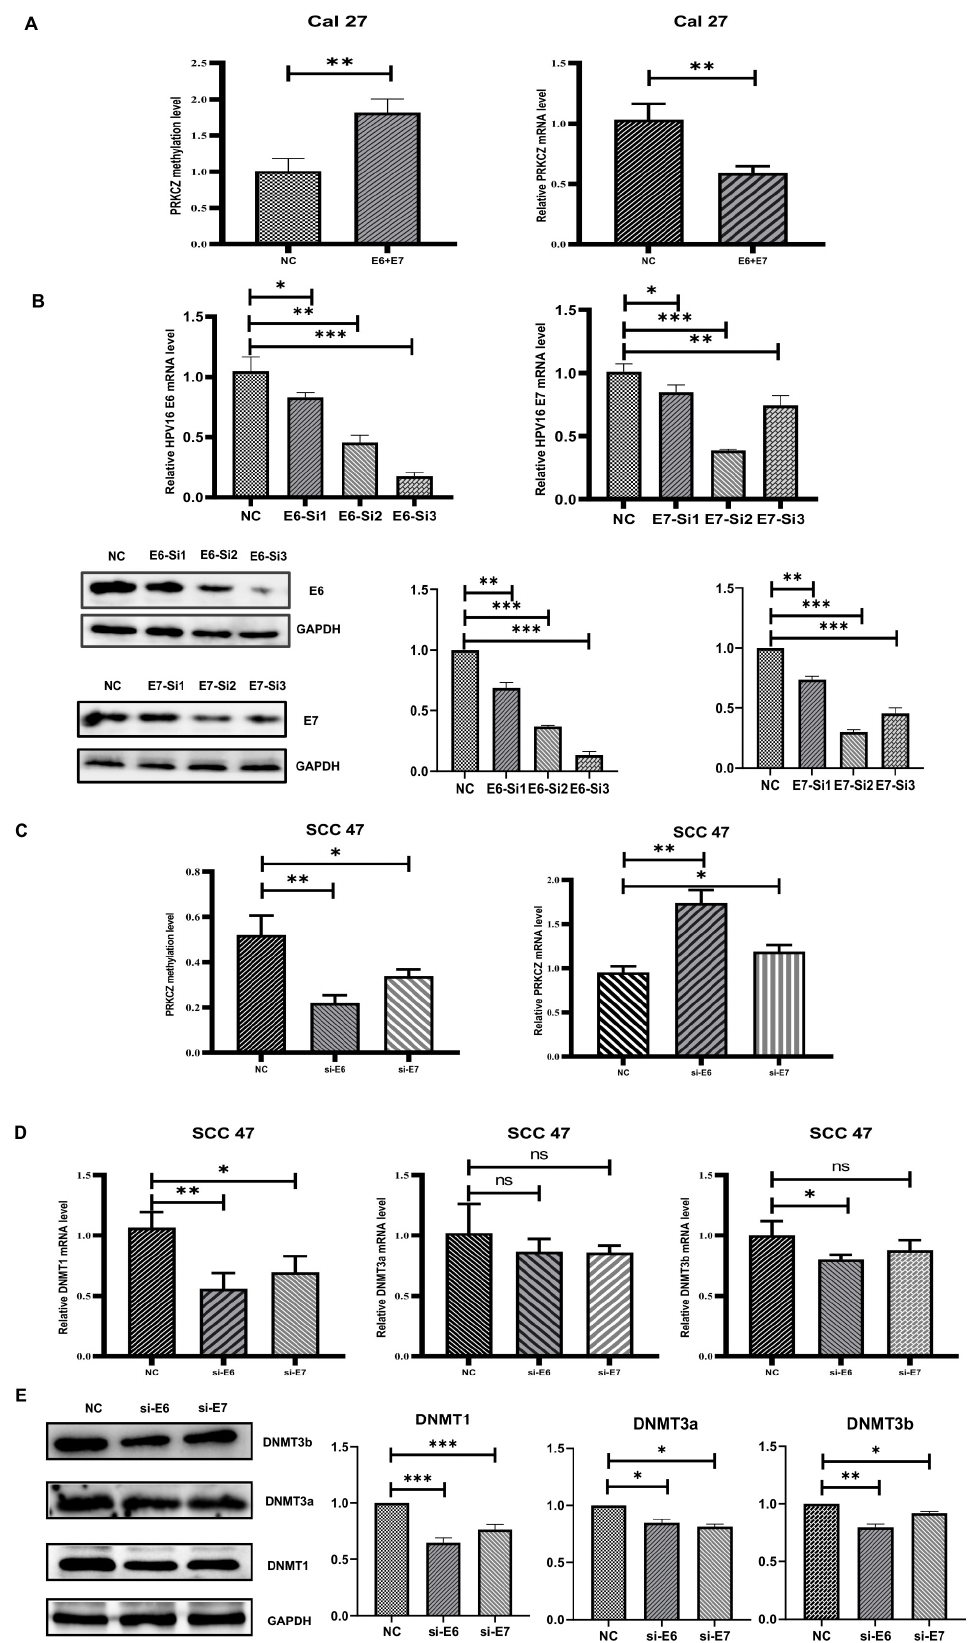
Figure 4. DNMT1 was necessary in HPV-E6 regulating PRKCZ hypermethylation. ( A ) The methyla- tion degree and mRNA level of PRKCZ in Cal27 after transfecting with E6 and E7 lentivirus